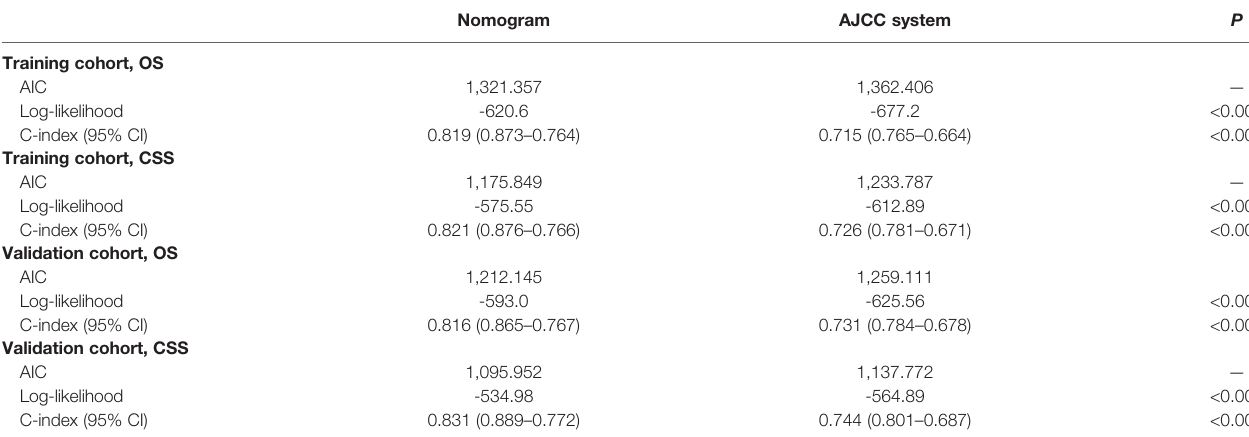
TABLE 5 | The comprehensive comparison between our nomograms and the current 7th AJCC staging